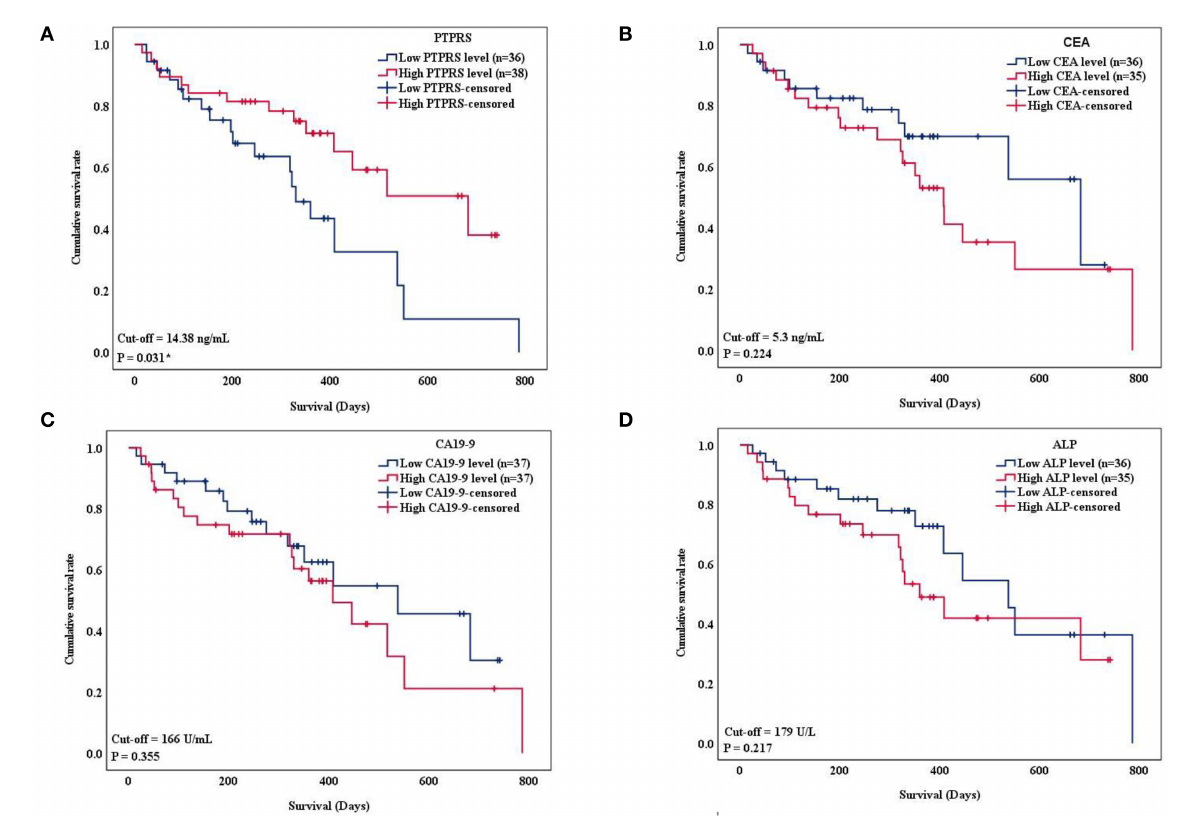
FIGURE4 Kaplan-Meier curves show overall survival (OS) of patients with CCA based on the serum level of PTPRS, CEA CA19-9, and ALP, respectively. The curves showed OS of patients with CCA having a high level (red line) and low level (blue line) of the markers. The survival times were analyzed between high and low expression groups of (A) serum PTPRS level, (B) CEA level (C) CA19-9 level, and (D) ALP level (log-rank test; P = 0.031, 0.224, 0.355, and 0.217 respectively). * Statistically significant ( P < 0.05).